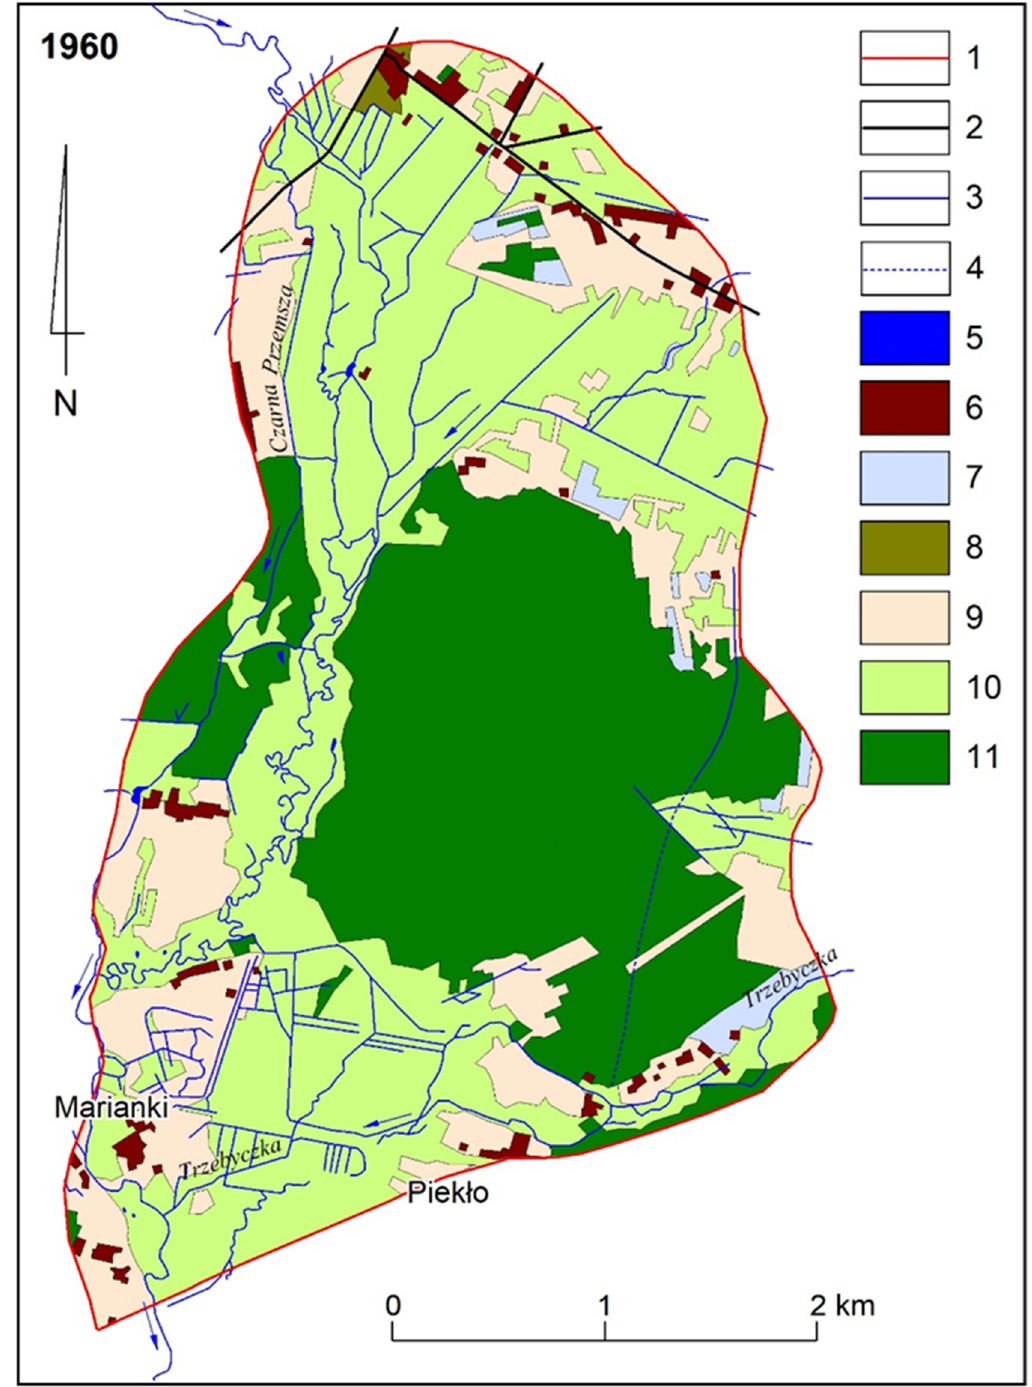
Figure 3. Changes in land use in the area of Ku ź nica War ęż y ń ska for the year 1960: 1—border of the